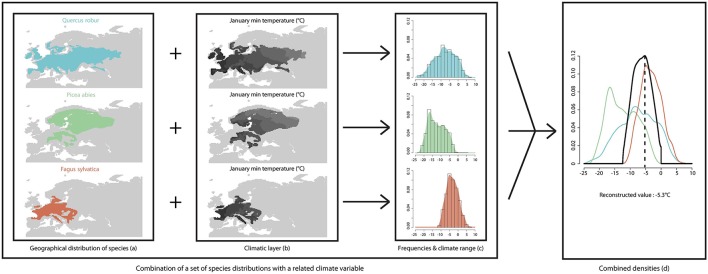
Schema summarizing the approach used for quantifying a past climate variable from a set of plant species that has been matched to a fossil pollen assemblage. The modern species ranges are obtained from a plant database (A). The climate variable (January temperature) is obtained from the WorldClim database (Hijmans et al., 2005; B). A probability density function (pdf) is used to infer the species-climate relationship (C) and the combination of all pdfs provides the intersecting value (D).